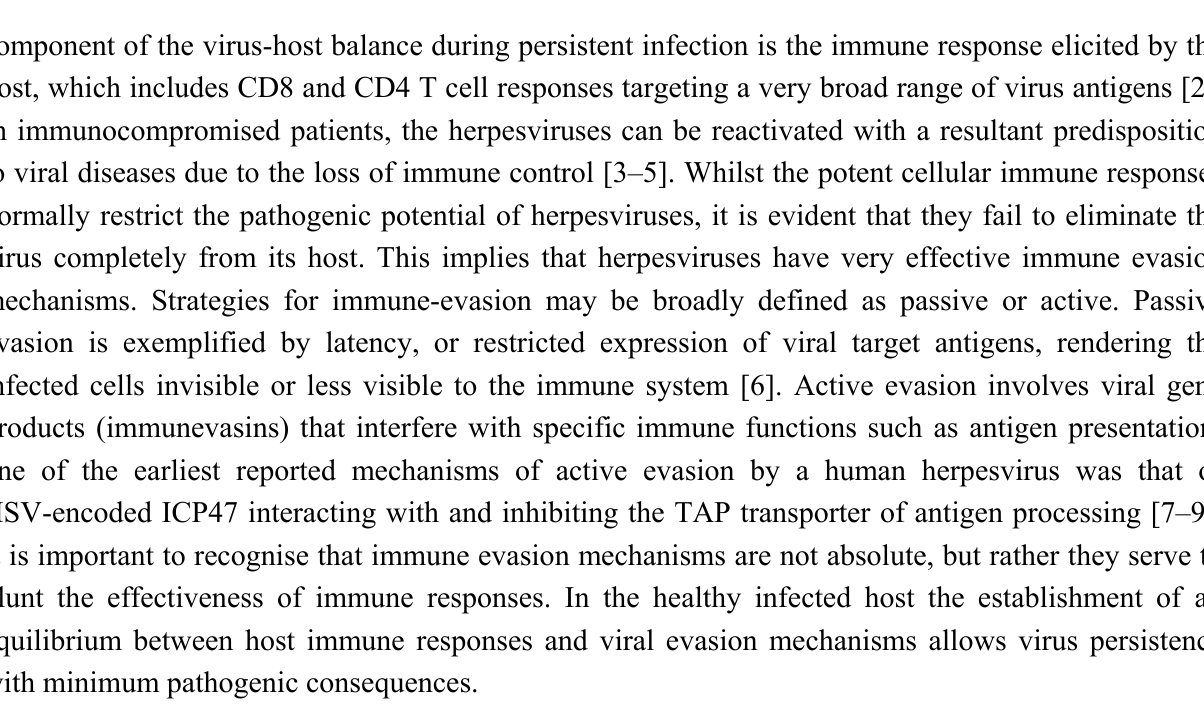
Table 1. Herpes viruses and their associated